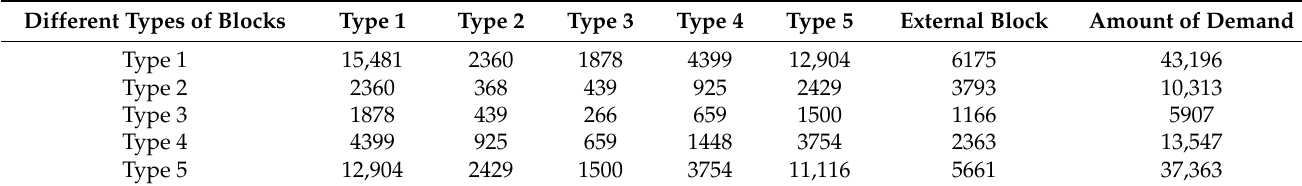
Table 3. Taxi travel demand balance table for various types of